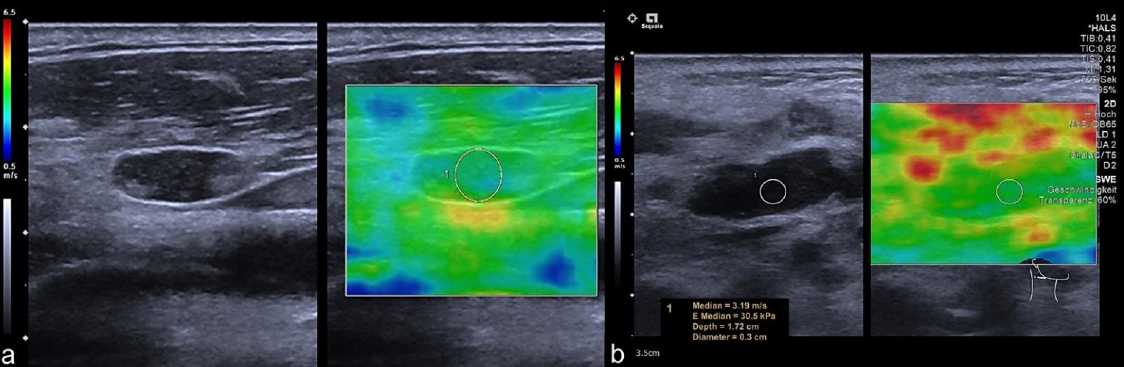
Figure 4. Representative SWE approach in regular CLN on B-mode US. Both CLN showed regular Solbiati Index > 2 without decreased long-axis diameter. Shear wave velocity on SWE was slightly high in Case 1 ( a ) and high in Case 2 ( b ) visualized by color-coded 2D-SWE maps and clarified by a value of 3.19 m/s in Case 2 (Figure 2b). Both CLN showed no parametric abnormalities in B-Mode US. Nevertheless, tissue stiffness on SWE was significantly increased compared to benign CLN, as representatively shown in Figure